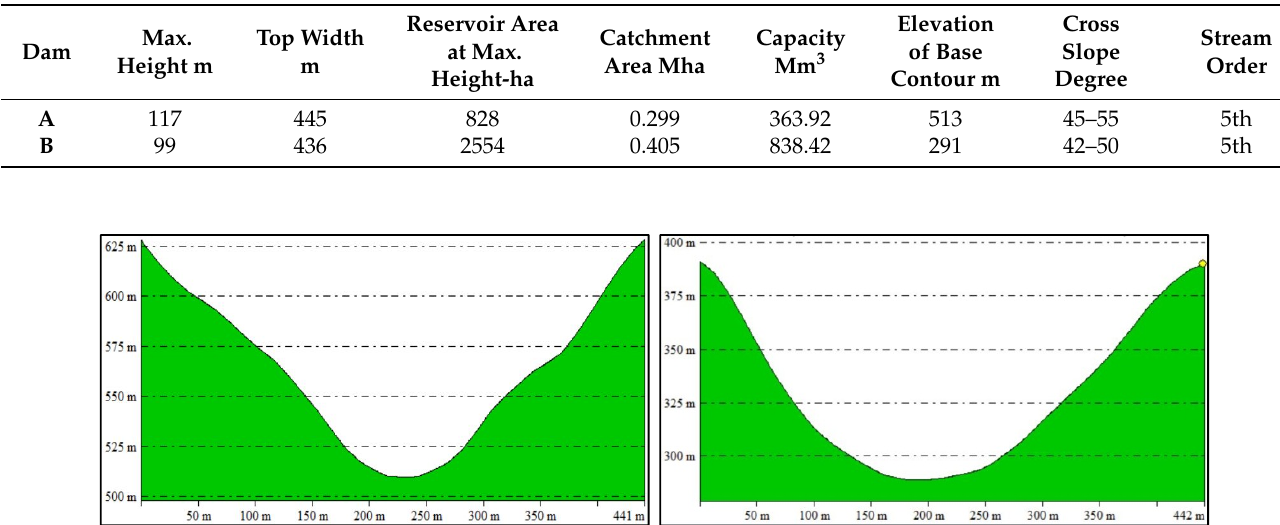
Figure 5. Cross-sectional profile of Dam-A (left) and Dam-B (right).